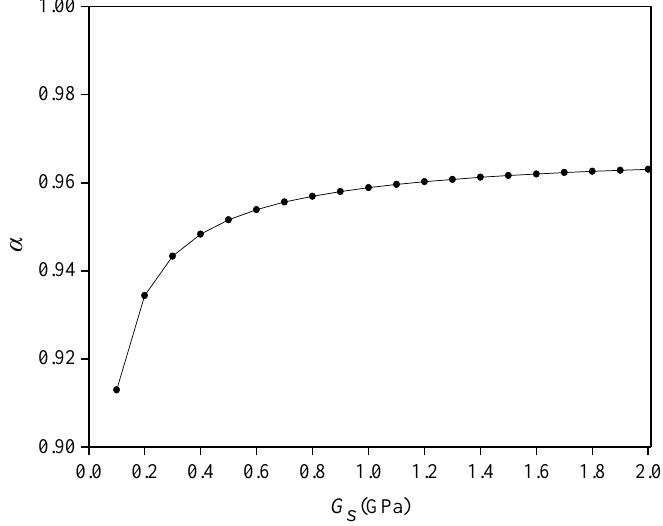
Figure 7. Relationship between shear modulus and average strain-transfer coefficient.